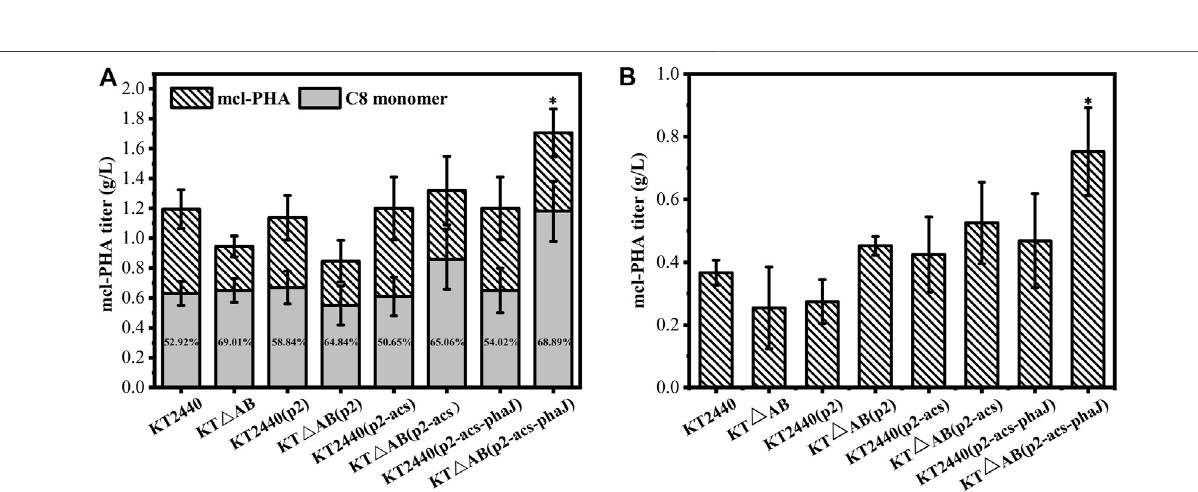
FIGURE6| Theengineeredstrain P.putida KT Δ AB(p2-acs-phaJ)wasusedtoproducemcl-PHAbyfermentation withmixedsubstrates (A) P.putida KT Δ AB(p2- acs-phaJ) was used to produce mcl-PHA in a two-step fermentation with a mixed substrate comprising 10 g/L glucose and 2 g/L octanoate (B) P. putida KT Δ AB (p2- acs-phaJ)wasculturedwith5 g/Lglucoseand5 g/Laceticacidasasubstratefor24 h,afterwhich2 g/Loctanoatewasadded,andthefermentationwascontinuedfor 72 h to measure the fi nal mcl-PHA titer. The error bars indicate the standard deviation of triplicate experiments. * p < 0.05; ** p < 0.01; *** p < 0.001; ns, no signi fi